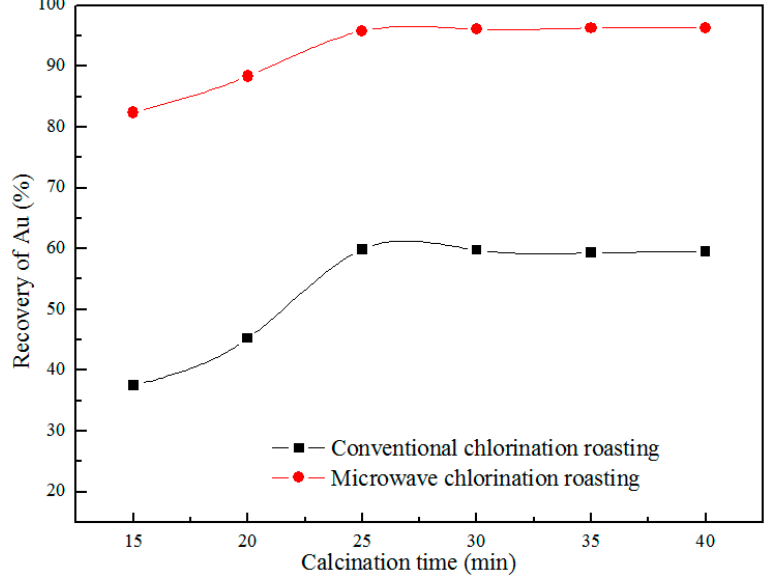
Figure 6. Effect of holding time on recovery of Au.